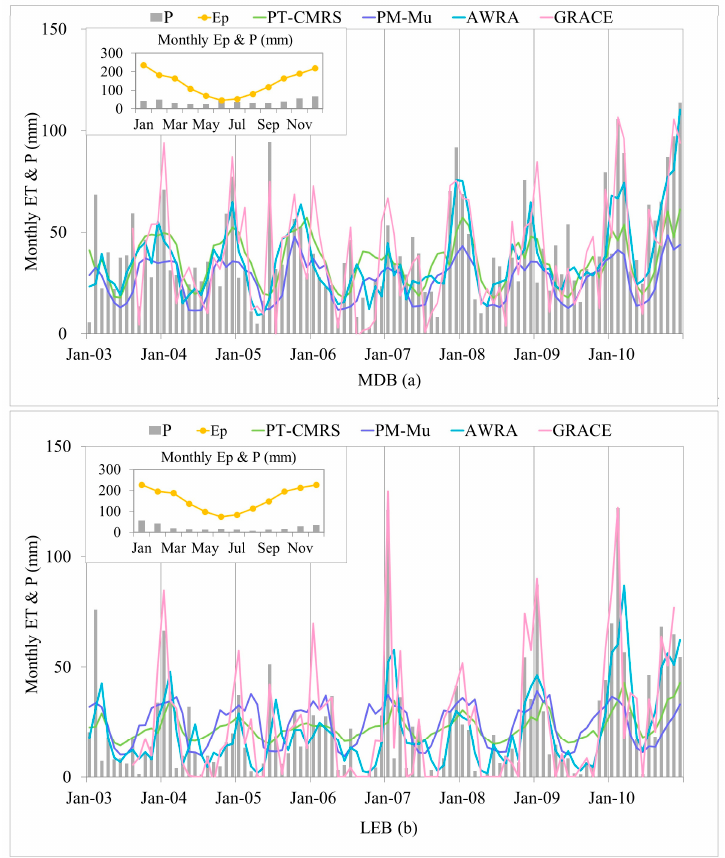
Figure 4. Monthly ET time series derived from the four ET datasets with rainfall and potential evaporation ( E p ) over the MDB ( a ) and LEB ( b ) from 2003 to 2010.